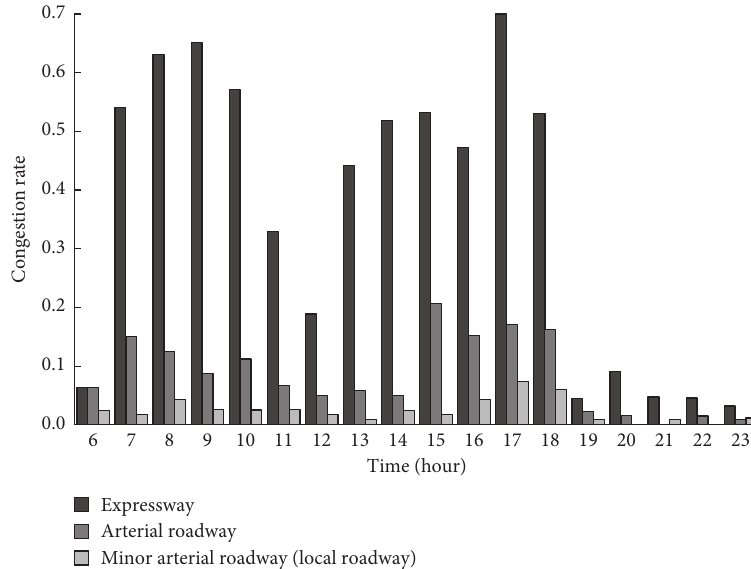
Figure 6: The traffic congestion ratio of each grad of roadway sections on